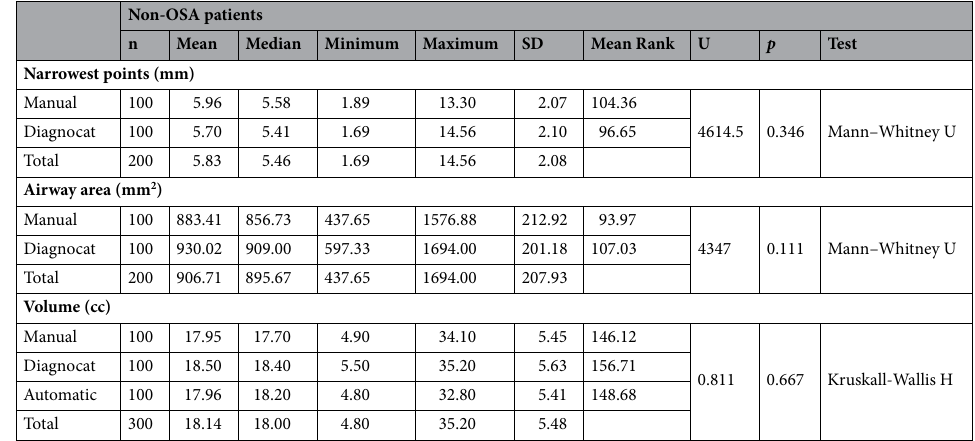
Table 2. Comparison of airway volume, airway area, and narrowest line of the airway measurements of Diagnocat, manual technique, and automatic technique in patients without OSA.